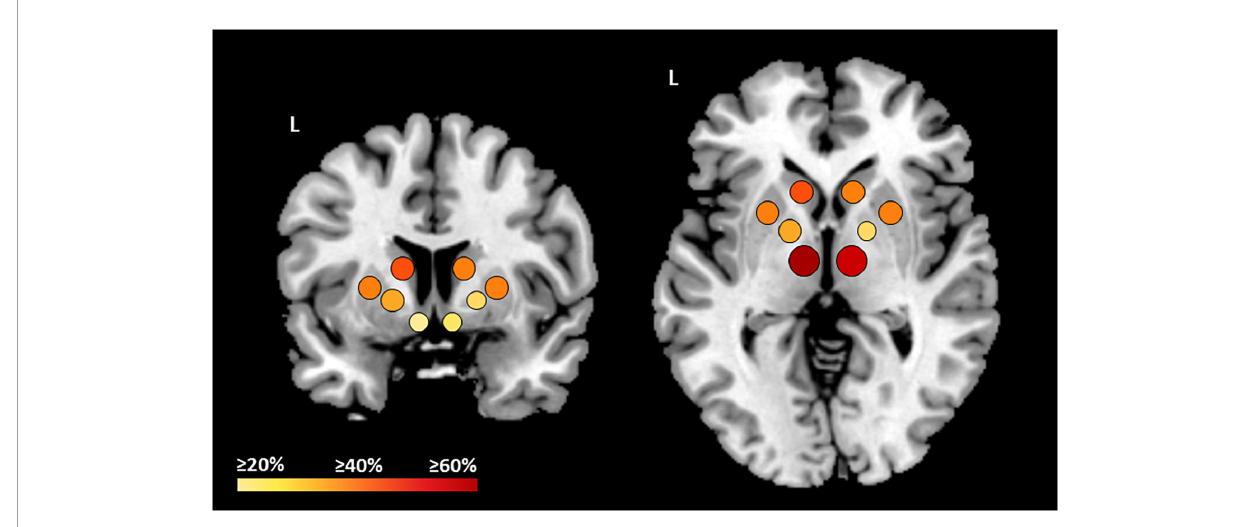
FIGURE2 Overview on the 53 reported studies which observed alterations of BG in ALS patients. The color shades and size of the dots represent the amount of studies which observed structural and/or functional alterations in each structure. Bigger and red dots mean ≥ 60% studies, orange and medium dots mean ≥ 40% studies, and small and yellow dots mean ≥ 20% studies. L,